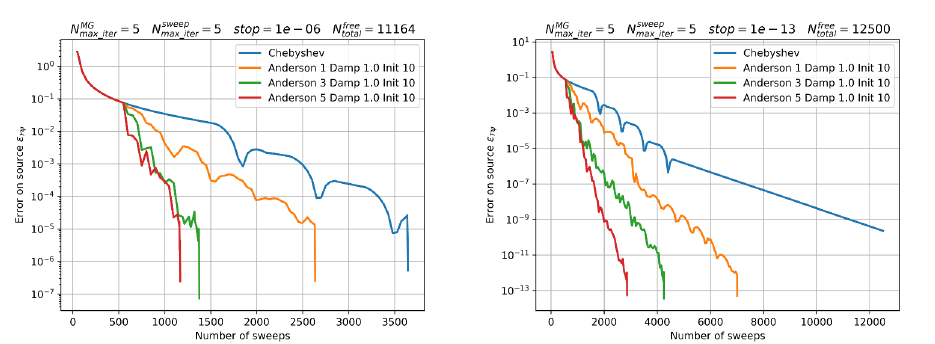
Figure 4: Anderson vs. Chebyshev with stopping criteria of 10 − 6 (left) and 10 − 13